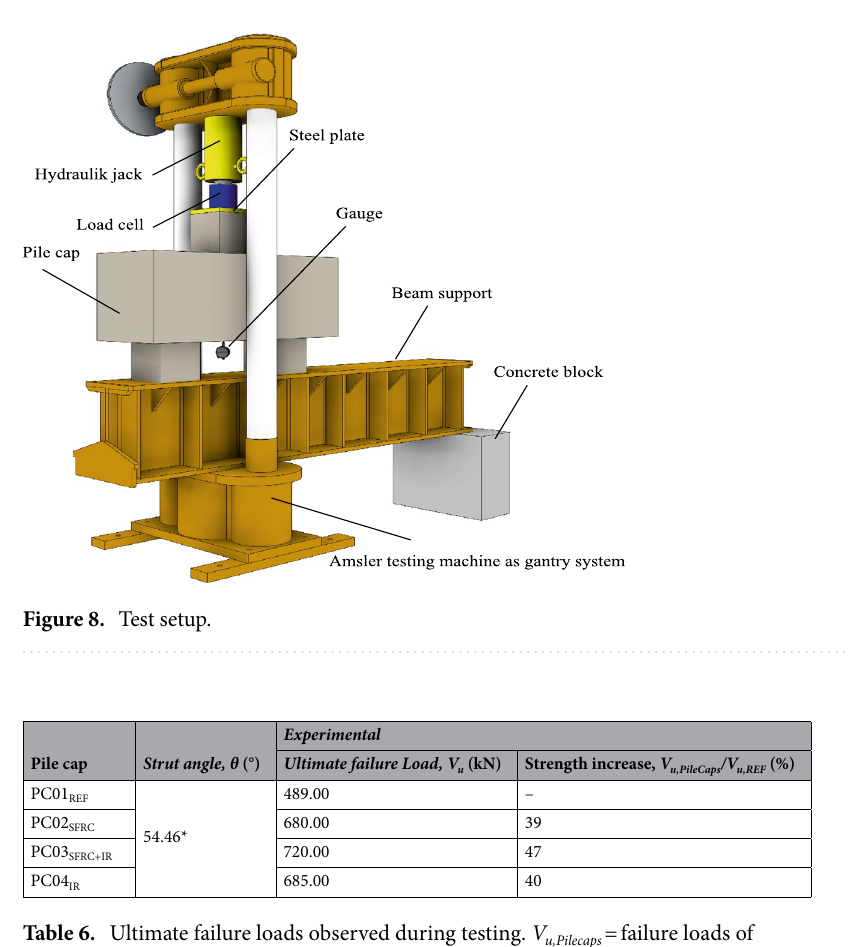
Table 6. Ultimate failure loads observed during testing. V u,Pilecaps = failure loads of the pile caps with steel fibers and/or inclined reinforcement V u,REF = failure loads of the pile caps without steel fibers and/or inclined reinforcement. * From Eq. (1), tan θ = d /( 0.5 · L − 0.25 · a c ) = 350 /( 0.25 · 600 − 0.25 · 200 ) = 1.4 → arctn θ = 54.46 .